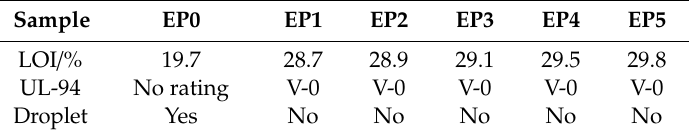
Table 2. LOI and UL-94 date of